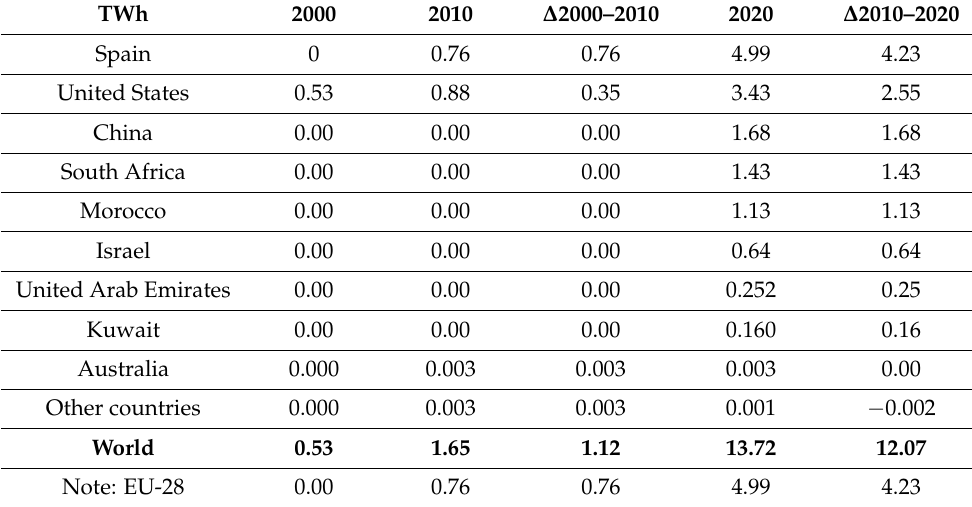
Table 7. Solar thermal power generation (TWh) (based on [26]).